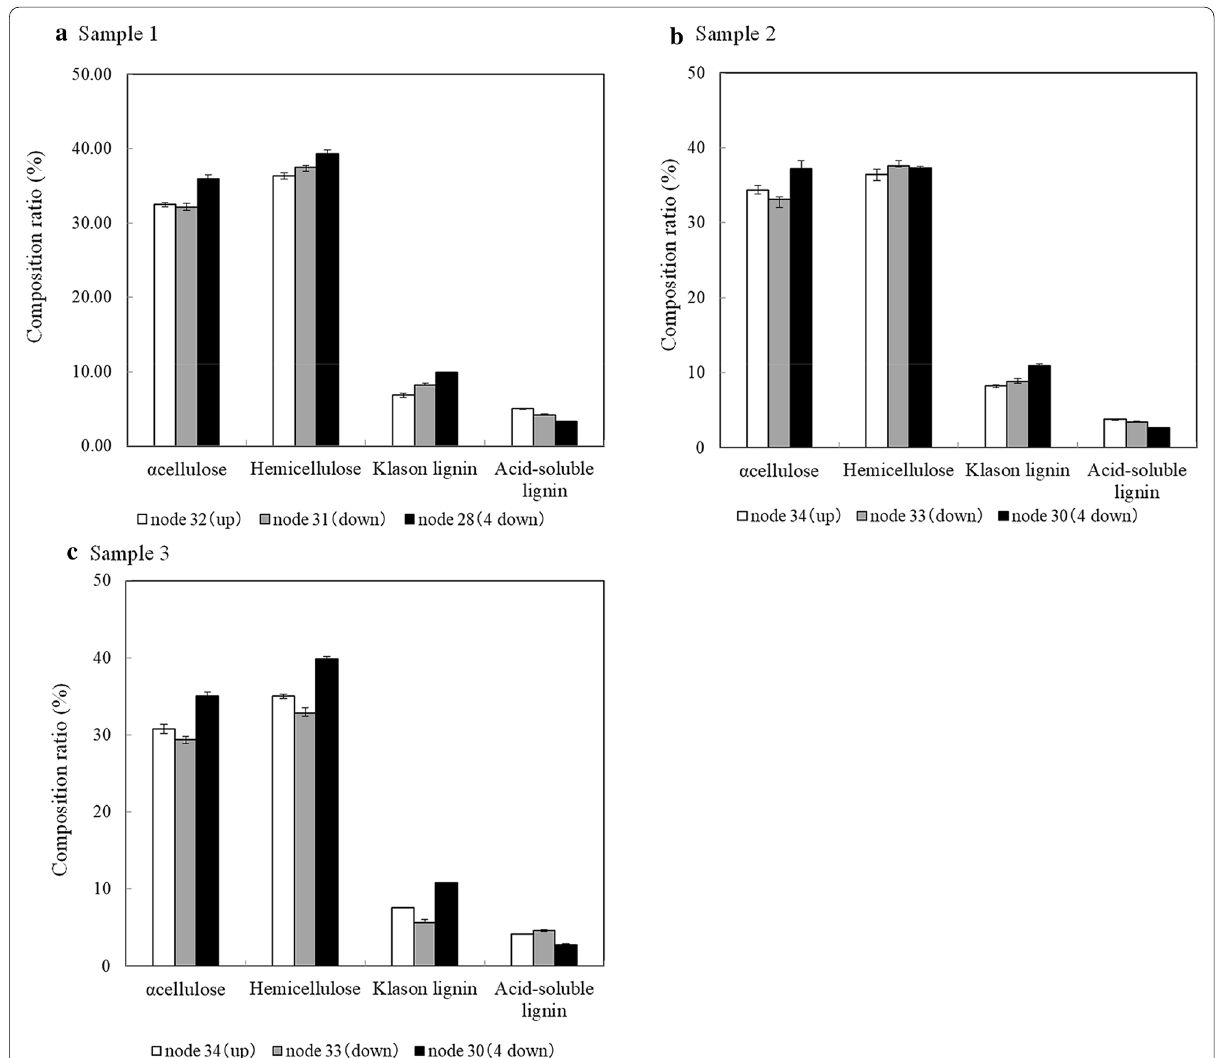
Fig. 2 Compositional ratios of the major components in the “Uradome” upper and lower sections. Compositional ratios of the major components of the upper and lower “Uradome” sections of the three samples. a sample1, b sample2, c sample3. Bar: